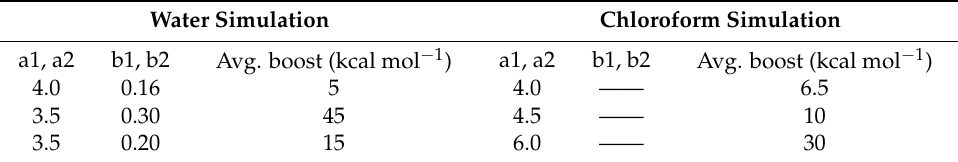
Table 5. Summary of coefficient a1, a2 and b1, b2 applied to consecutive simulations and the resulting average boost